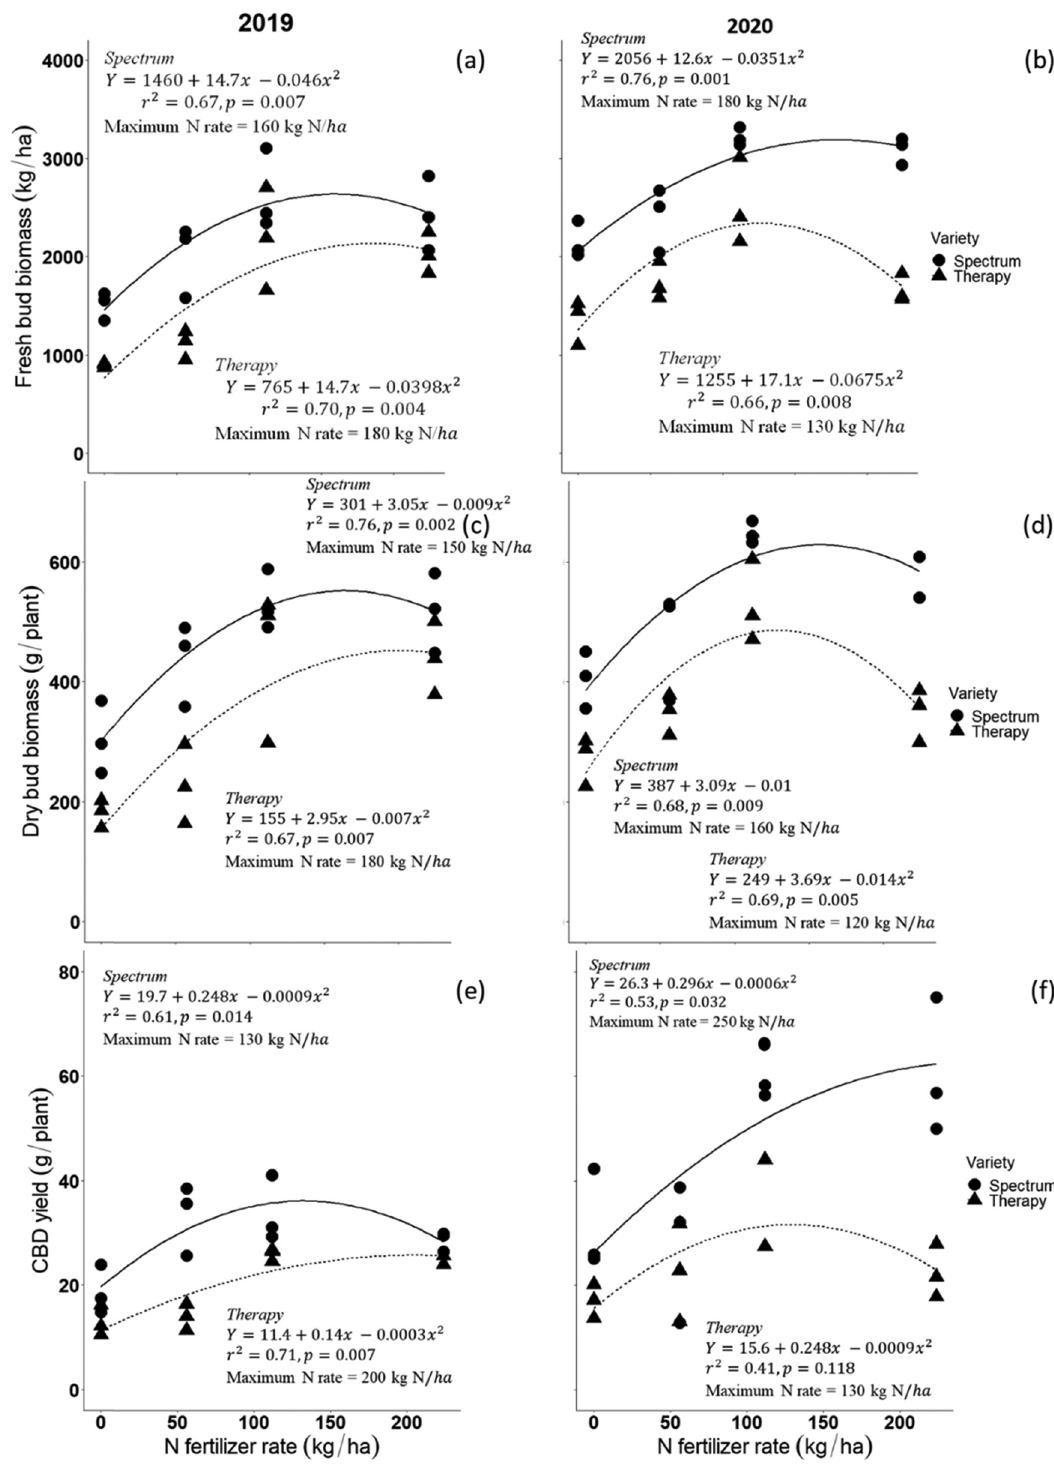
Figure 2: Relationship between fresh and dry bud biomass, and cannabidiol ( CBD ) yield of two CBD hemp varieties and nitrogen fertilization: ( a ) Fresh bud biomass in the year 2019; ( b ) fresh bud biomass in the year 2020; ( c ) dry bud biomass in the year 2019; ( d ) dry bud biomass in the year 2020; ( e ) CBD yield in the year 2019; and ( f ) CBD yield in the year 2020. The symbols show the data distribution, and the curves are the best - fi t regression relationship with p <